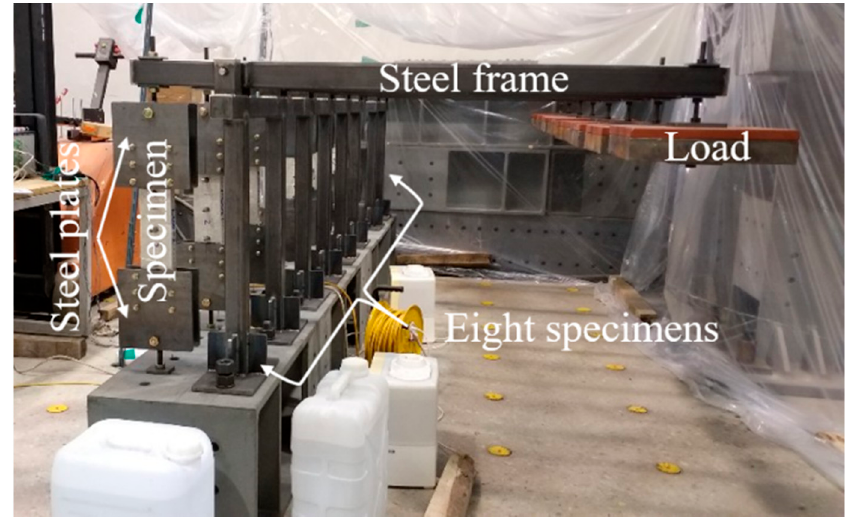
Figure 7. Photo of the test setup of TRM coupons subjected to sustained load.